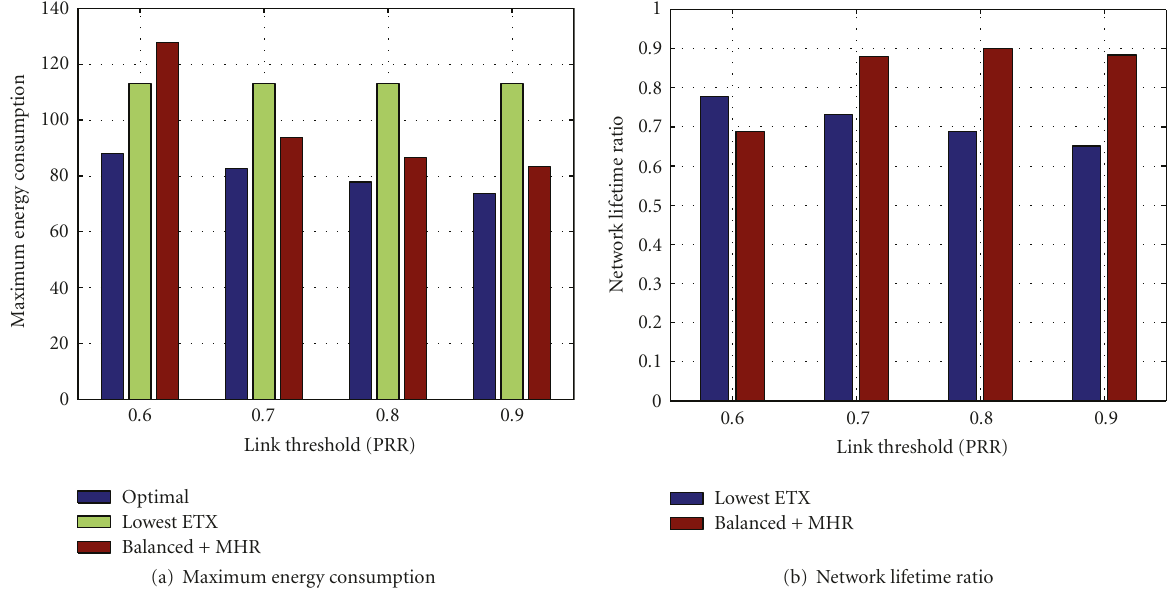
Figure 15: Comparison of the lowest ETX scheme and the balanced scheme in terms of (a) the maximum energy consumption and (b) the network lifetime normalized to the optimal network